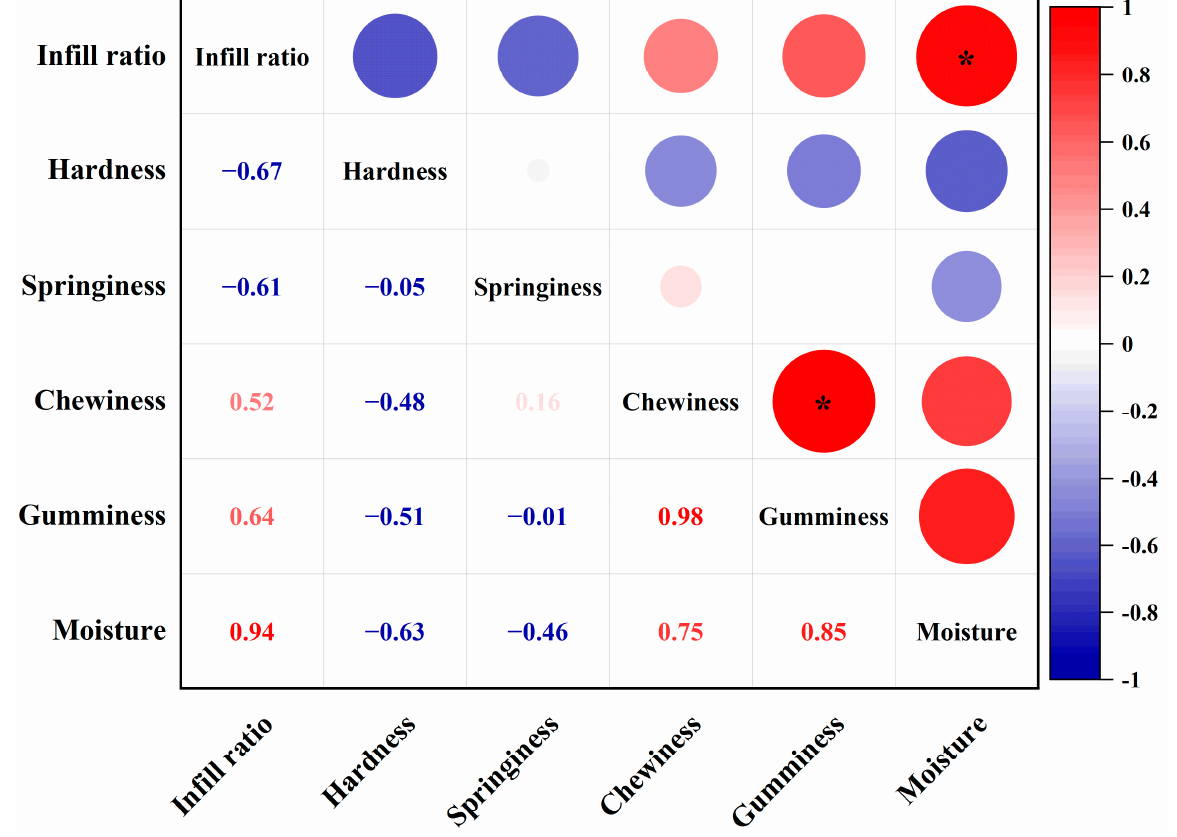
Figure 6. Pearson correlation analysis of the infilling ratio on the texture properties of 3D printed samples (* p < 0.05).